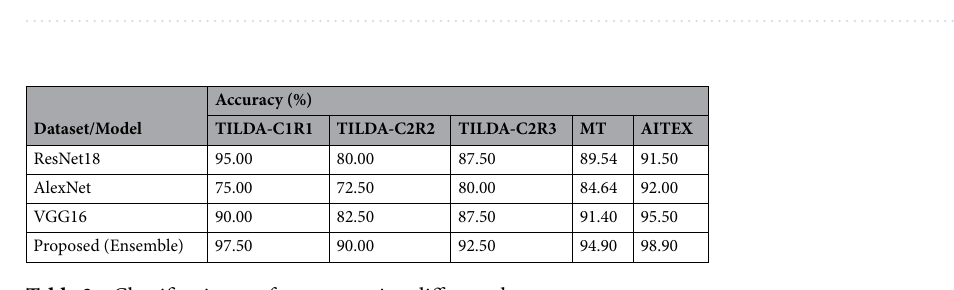
Figure 5. The graph representation of classification accuracy (mean) with different combinations of CNN models.